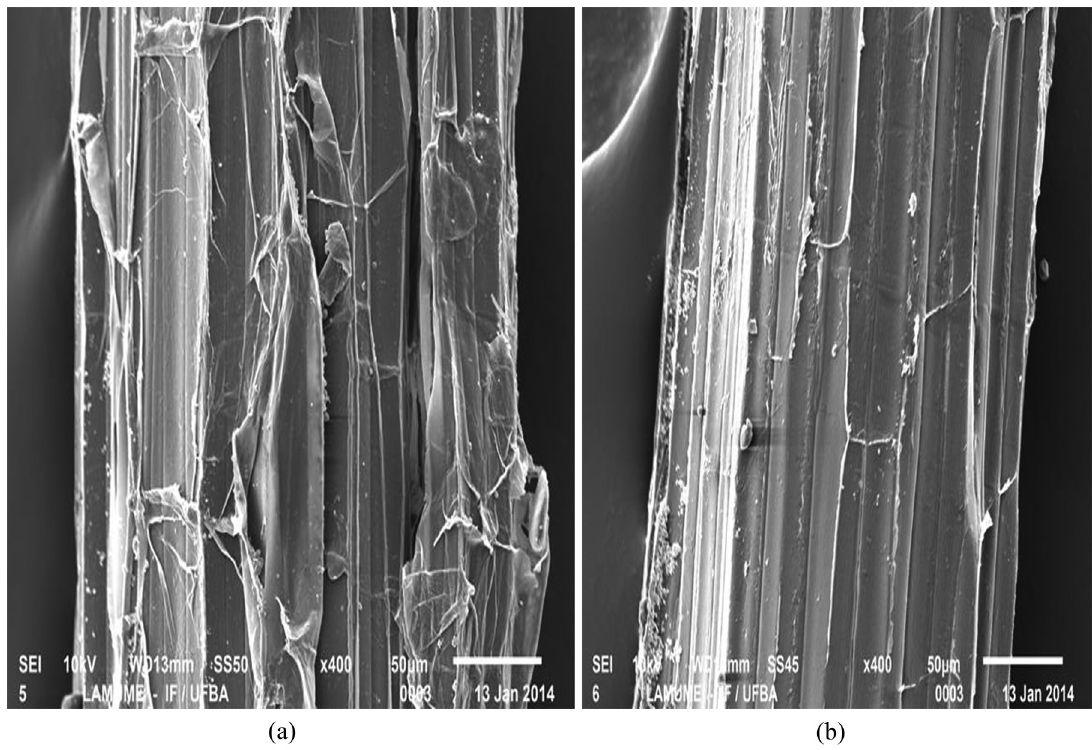
Figure 5. Micrographs of the surface of purple banana fibers in 400x in natura (a); treated